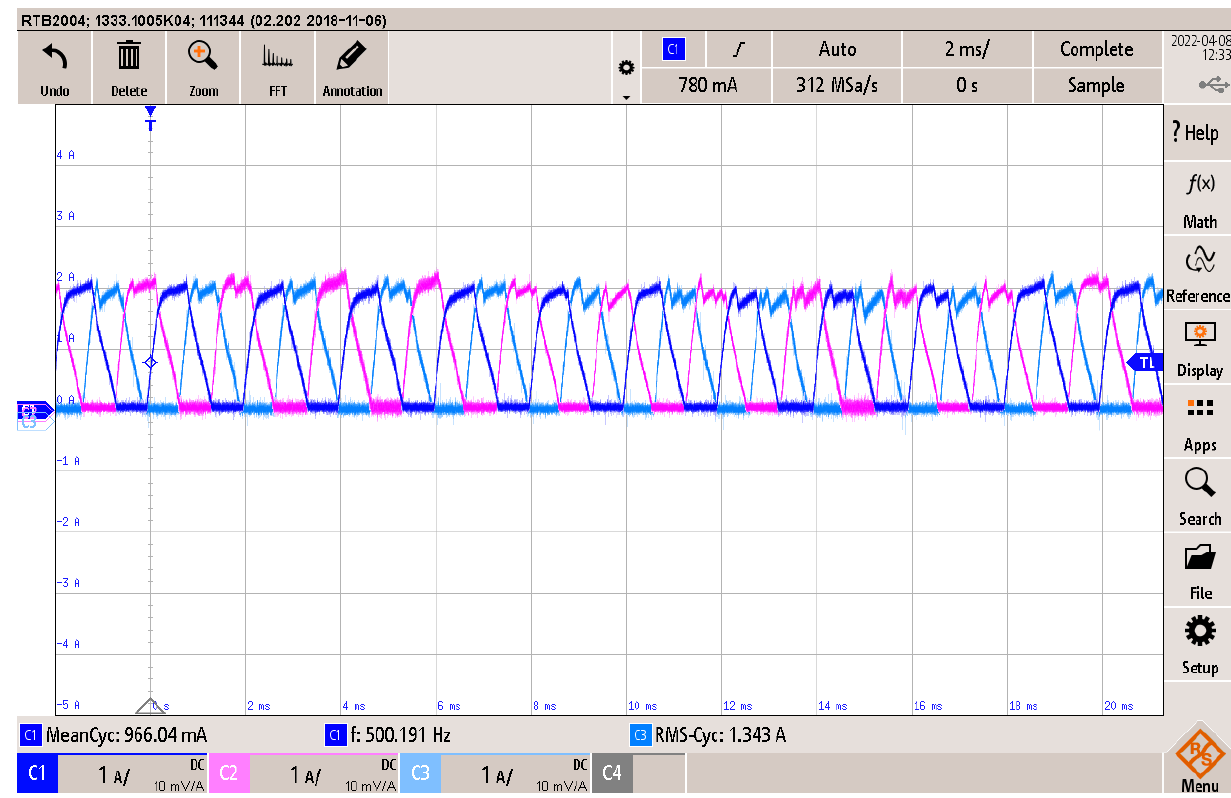
Figure 34. Phase currents of 6/10 SRM prototype in no-load operation at rated speed of 3000 rpm.